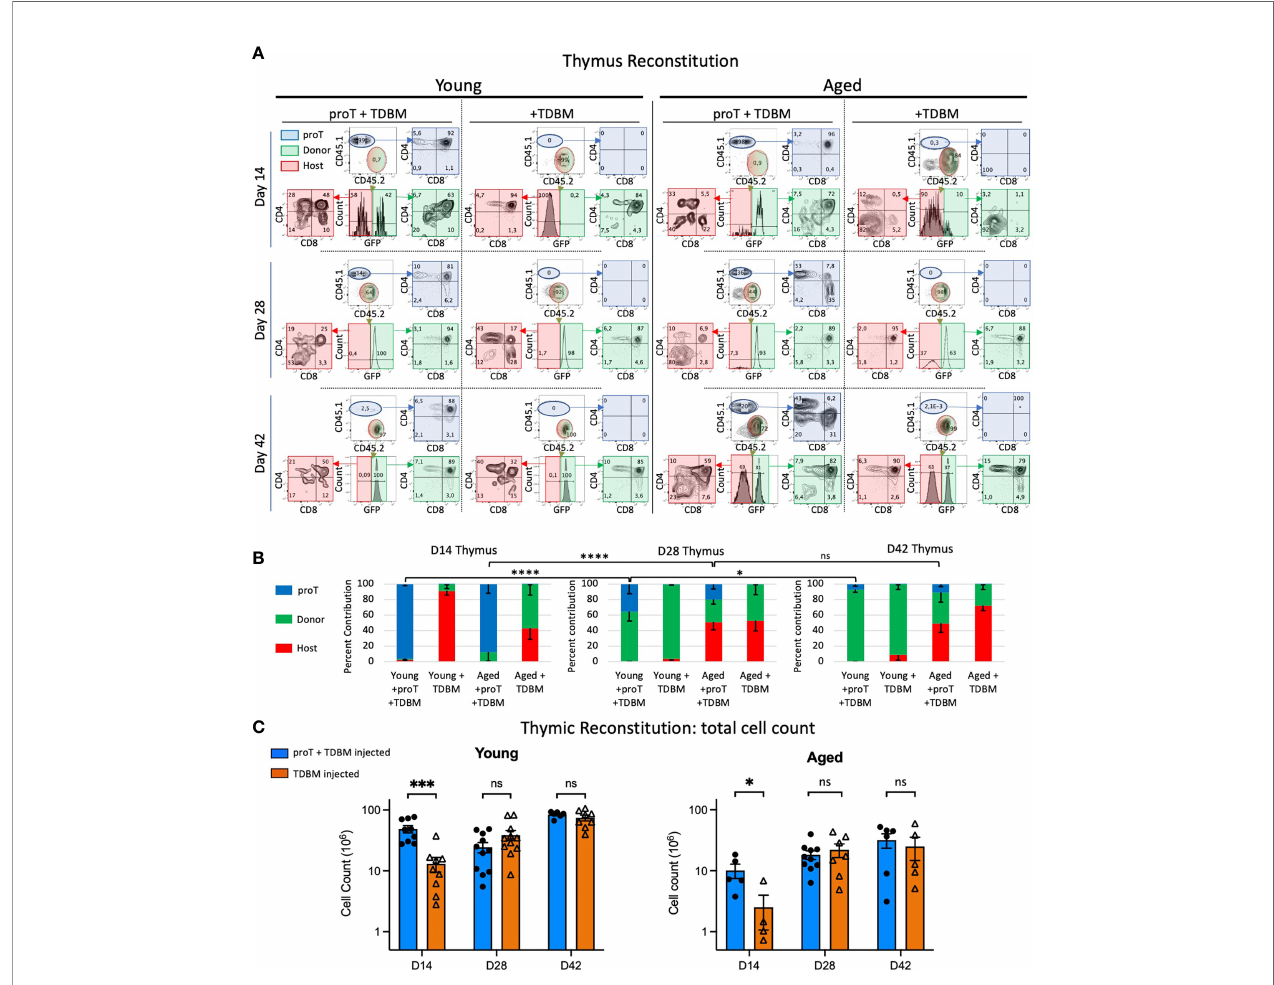
FIGURE 4 | Thymic engraftment of young and aged mice. Young (8-12wks) and aged (18-20 months) mice were treated with CTX followed by lethal irradiation in preparation for i.v. injection of either 4 x 10 6 proT cells derived from LSK/OP9-DL4 cocultures plus 1 x10 6 TDBM or 1 x10 6 TDBM alone as indicated. Thymus and other organs were harvested on days 14 (D14), D28 and D42. Thymocytes were labelled with appropriate lineage markers and analyzed by fl ow cytometry represented by plots shown in (A) . The thymocyte population was contributed by cells derived from the host (red), GFP + BM graft (green) and proT coculture (blue). The percent contribution of the source, whether host (CD45.2 + , GFP - ), BM graft-derived (CD45.2 + , GFP + ) or proT-derived (CD45.1 + ) is shown in (B) for the three timepoints. Total cell number of thymocytes is depicted in (C) with young in the left panel and the aged in the right panel. For all samples at all time points, n ≥ 4 up to 12. Error bars indicated SEM as indicated in Methods ; signi fi cance was measured with two-way ANOVA. *p<0.05, ***p<0.001,